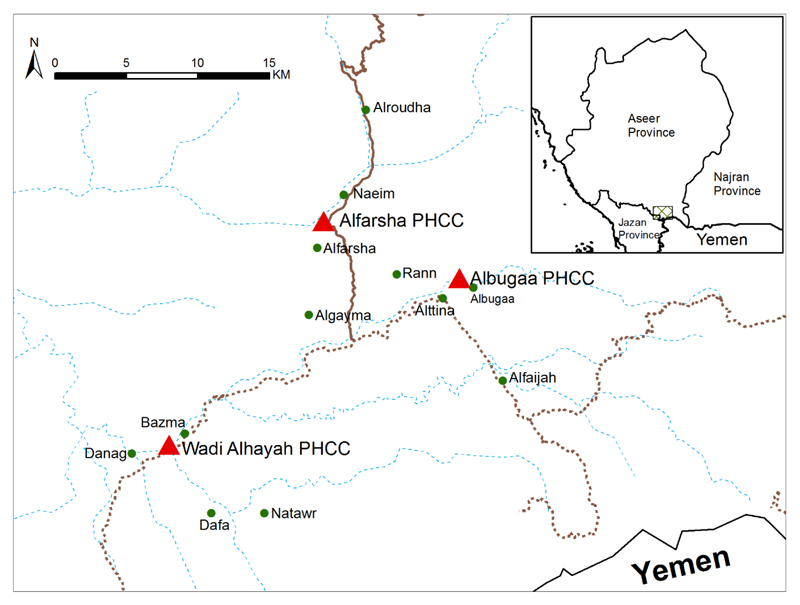
Map of the Tihama Qahtan study area showing the location of the three PHCCs (Red
triangles) and the 12 sampled villages (Green dots) used during cross-sectional
surveys. Insert map shows location of Aseer and study area in relation to region
and neighboring regions. Map digitized using ARCGIS version 10.1, ESRI, USA,
from maps provided by MoH, maps provided in [16] and other online digital GIS platforms [17,18].